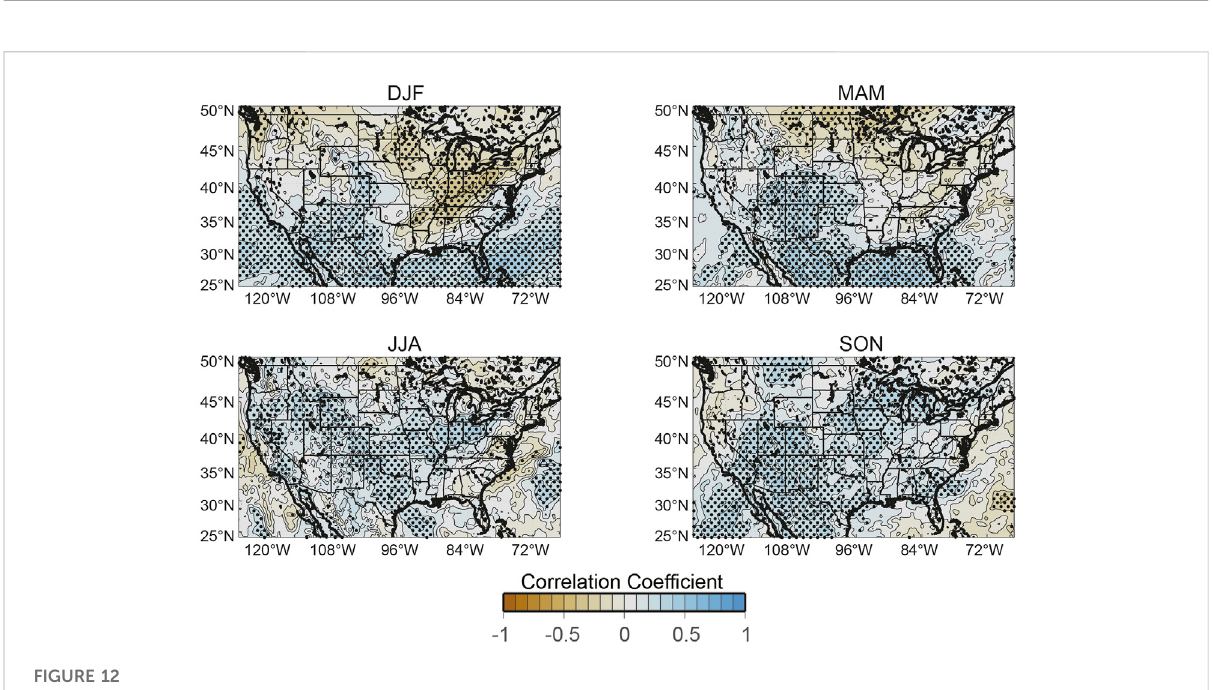
Khedun et al. (2012) elaborated on the distinction between the PDO ’ s winterandspringin fl uence(particularlywhenworkingintandemwith El Niño) on the upper vs. lower Rio Grande, thereby somewhat mitigating extremes in water availability. Pascolini-Campbell et al. (2017) showed the importance of the positive PDO (and negative